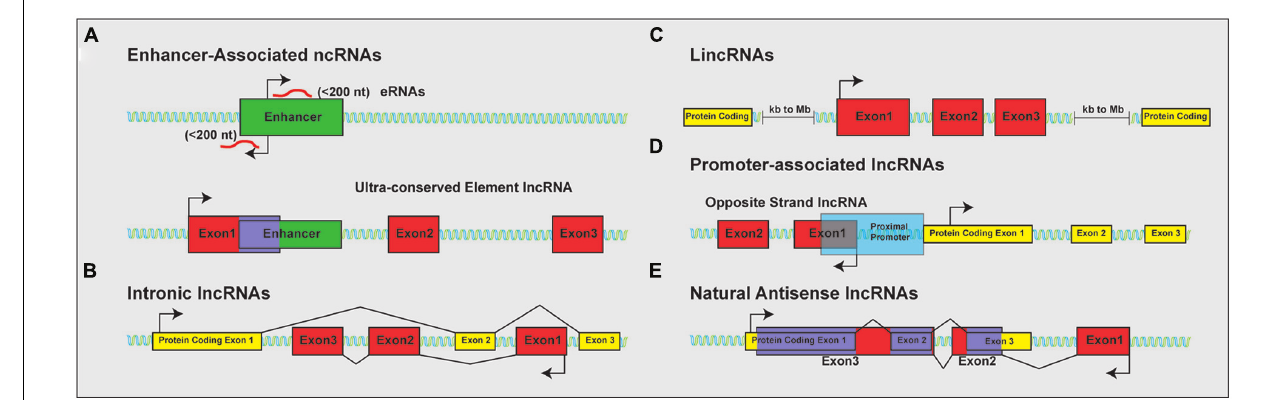
neighboring protein-coding genes. (D) Promoter associated lncRNAs are transcribed from segments within proximal promoters of the associated protein-coding gene on the anti-sense (opposite strand lncRNAs; shown) or sense (not shown) strand relative to the protein-coding gene. (E) Natural antisense lncRNAs are transcribed for the antisense strand of protein-coding genes and contain complementary sequences to segments of the mature mRNA. Protein-coding exons shown in yellow; lncRNA exons shown in red; overlapping sequence shown in